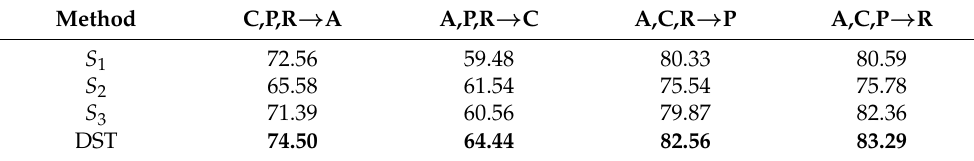
Table 4. Classification accuracy (%) with and without DST fusion strategy on Office-Home dataset.